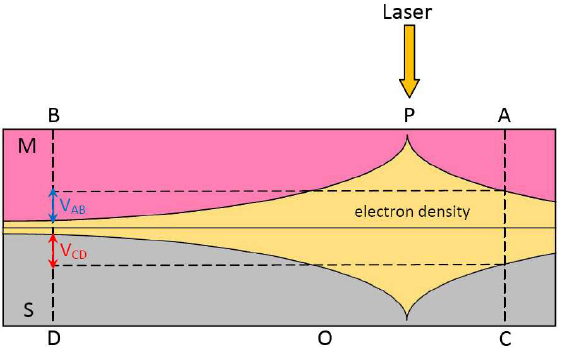
Figure 13. Diagram of laser-induced stable distribution of electron density in MS structure. The yellow part represents the distribution of density of laser-induced